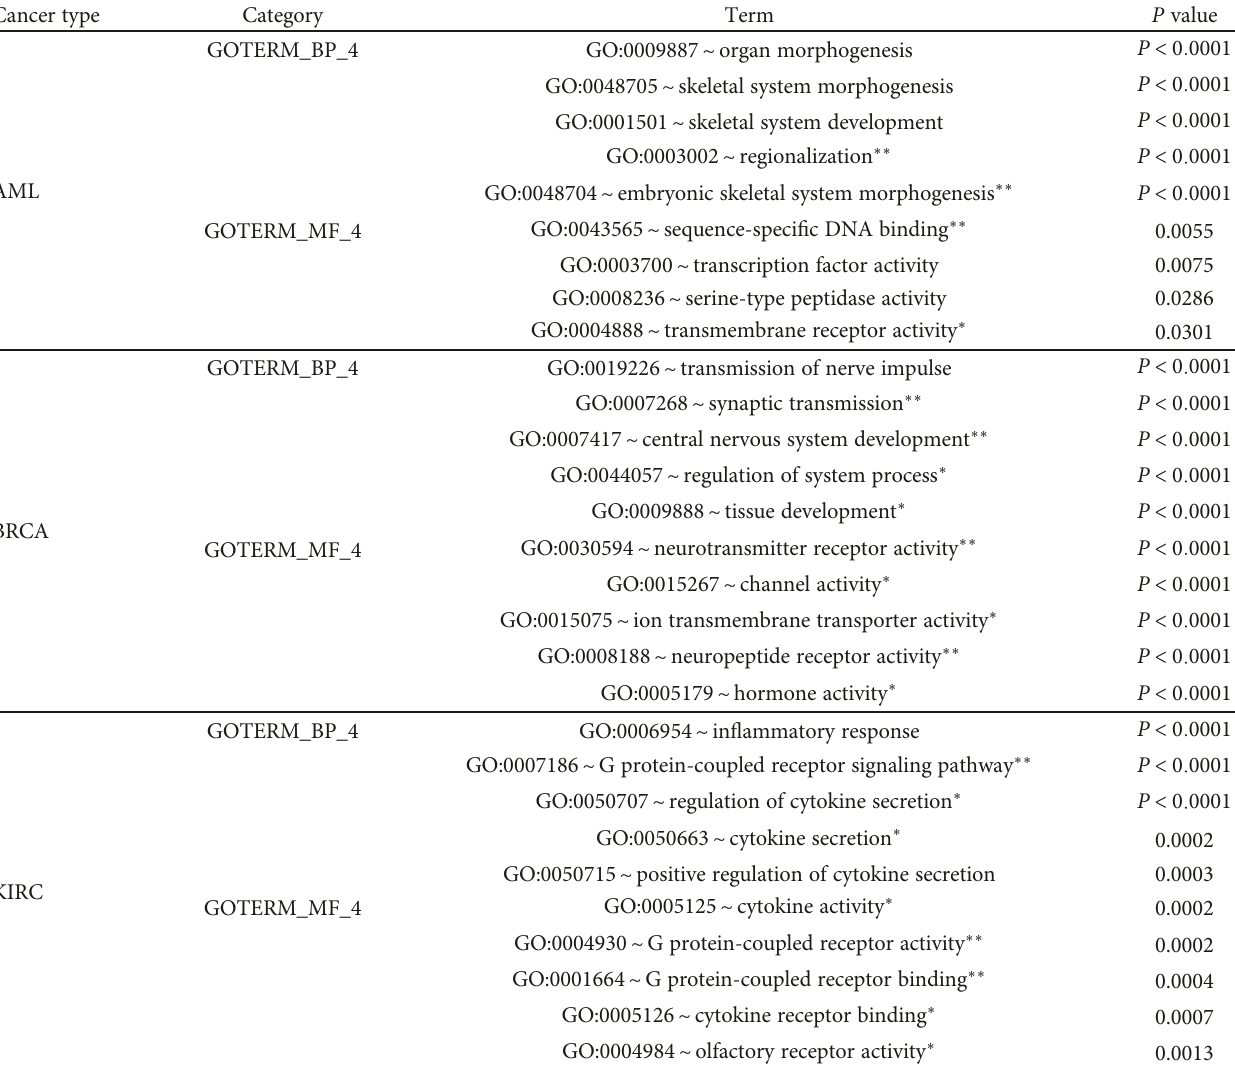
Table 5: The top 5 GO terms enriched with the genes connected with the cancer-speci fi c miRNAs. Cancer